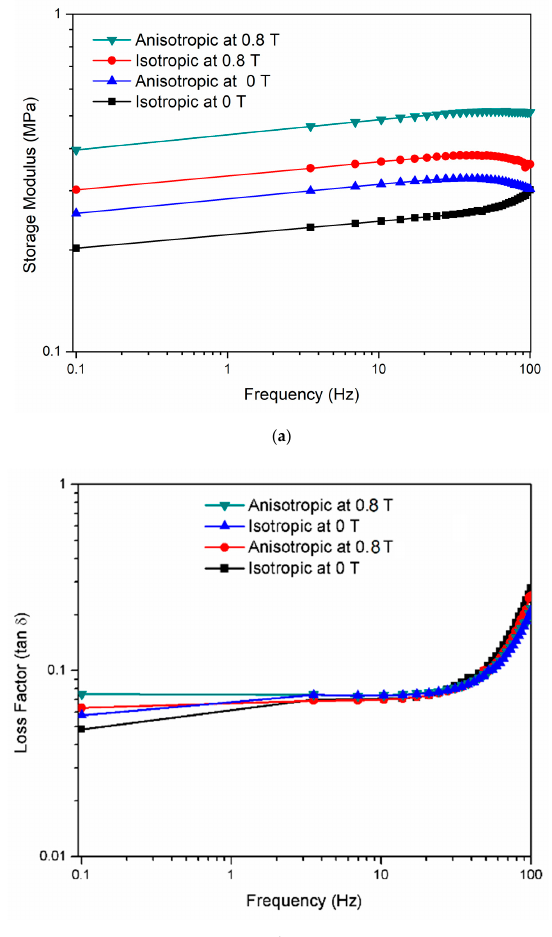
Figure 6. Storage modulus ( a ) and loss factor ( b ) of MRE under different magnetic flux densities as a function of frequency.